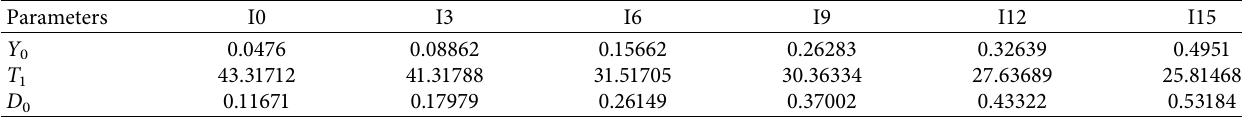
Table 5: Summary of fitting parameters of equation (9) and the initial damages quantified in Section